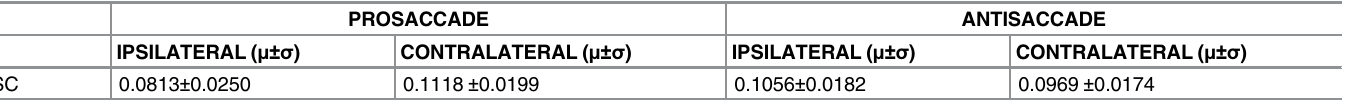
Table 5. Mean and standard error of normalised signal change for each saccade event